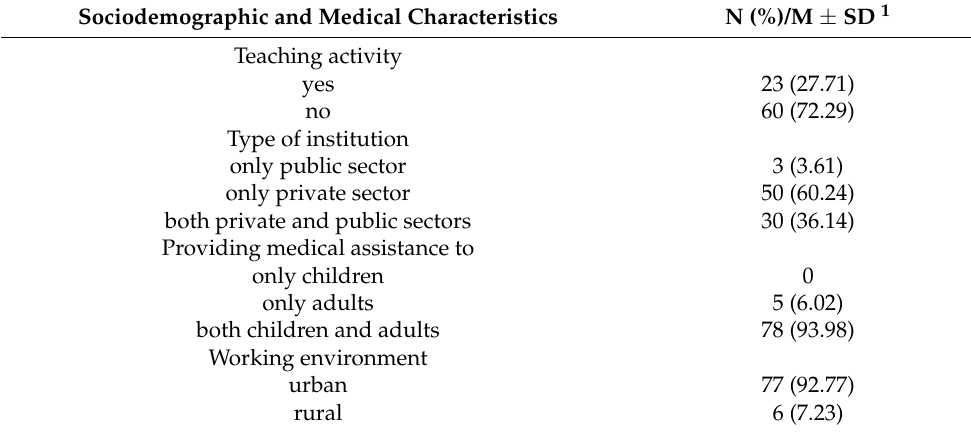
Table 1. Cont. Sociodemographic and Medical